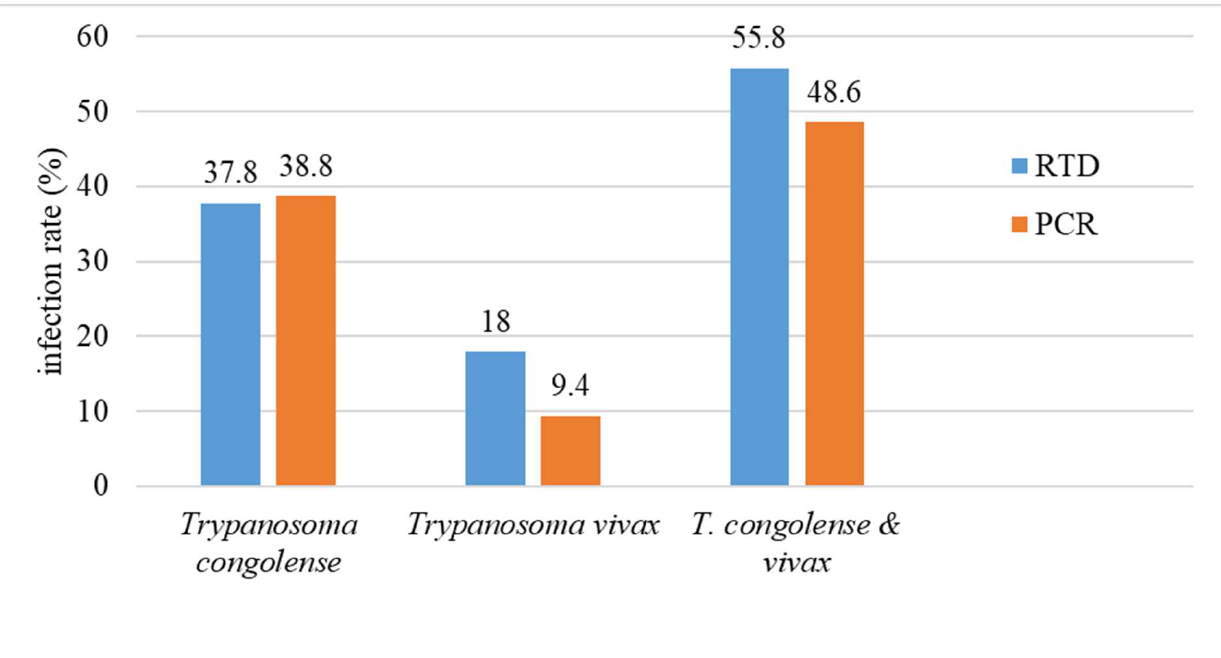
Figure 2. Comparison of the global T. congolense s.l. and T. vivax infection rates of cattle, regardless of the sampling villages, determined using either the PCR technique or the Very Diag Kit (RDT).